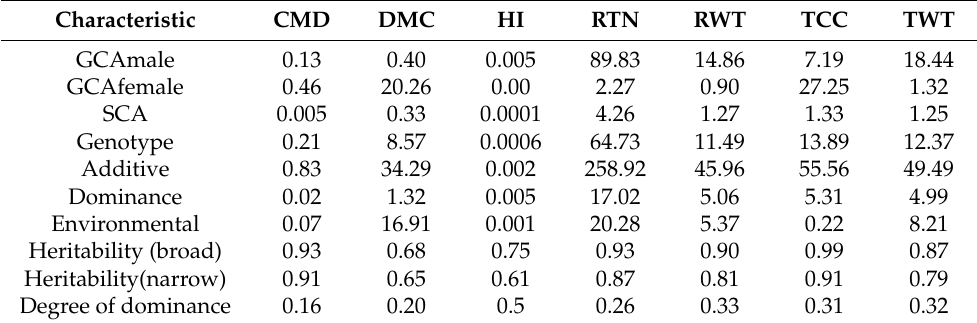
Table 7. Genetic parameters for various traits studied across two locations in